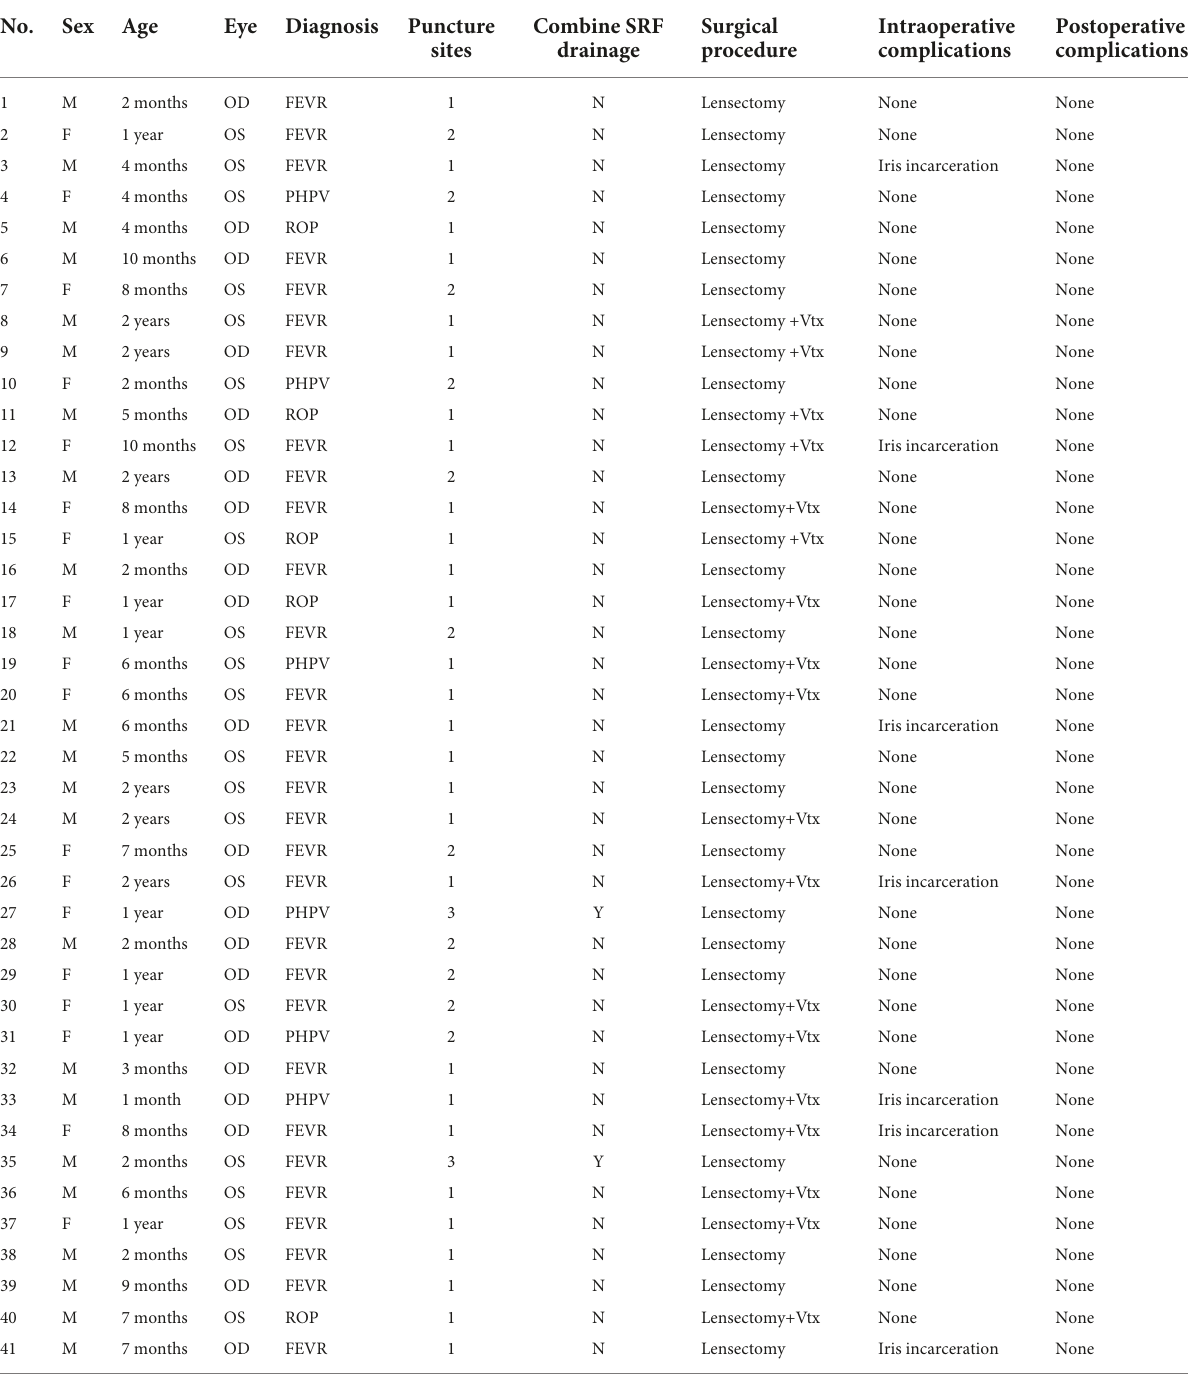
TABLE 2 Demographic information and surgical procedure of study